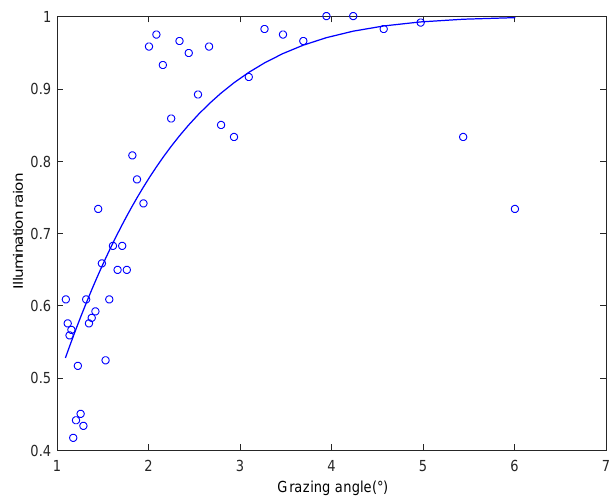
Figure 11. The calculated illumination as a function of grazing angle and the fitted Smith’s function. Figure 12 is the estimated RMS sea surface slope on each sector by fitting the Smith’s function.